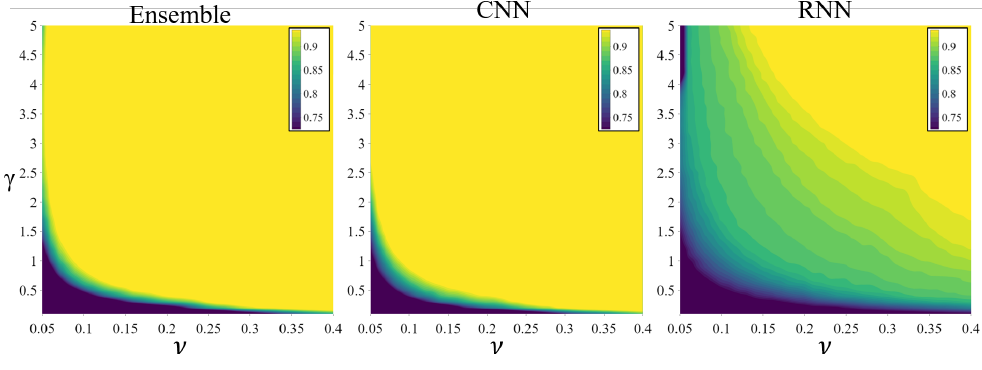
Figure 6. Comparison of the ACC, TPR, and TNR results as a function of γ and ν for the ensemble, convolutional neural network (CNN), and recurrent neural network (RNN). The same color denotes a similar rate (maximum 1% difference), with yellow indicating the highest